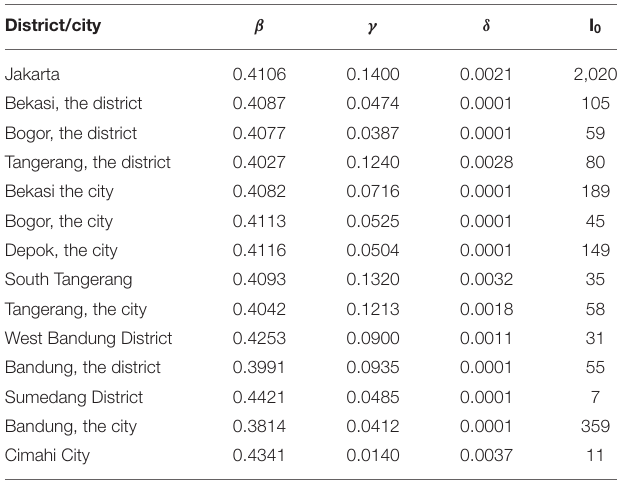
TABLE 2 | Estimated rate of transmission, recovery, and deaths due to COVID-19 in Jabodetabek and Jabaraya (district/city scale).